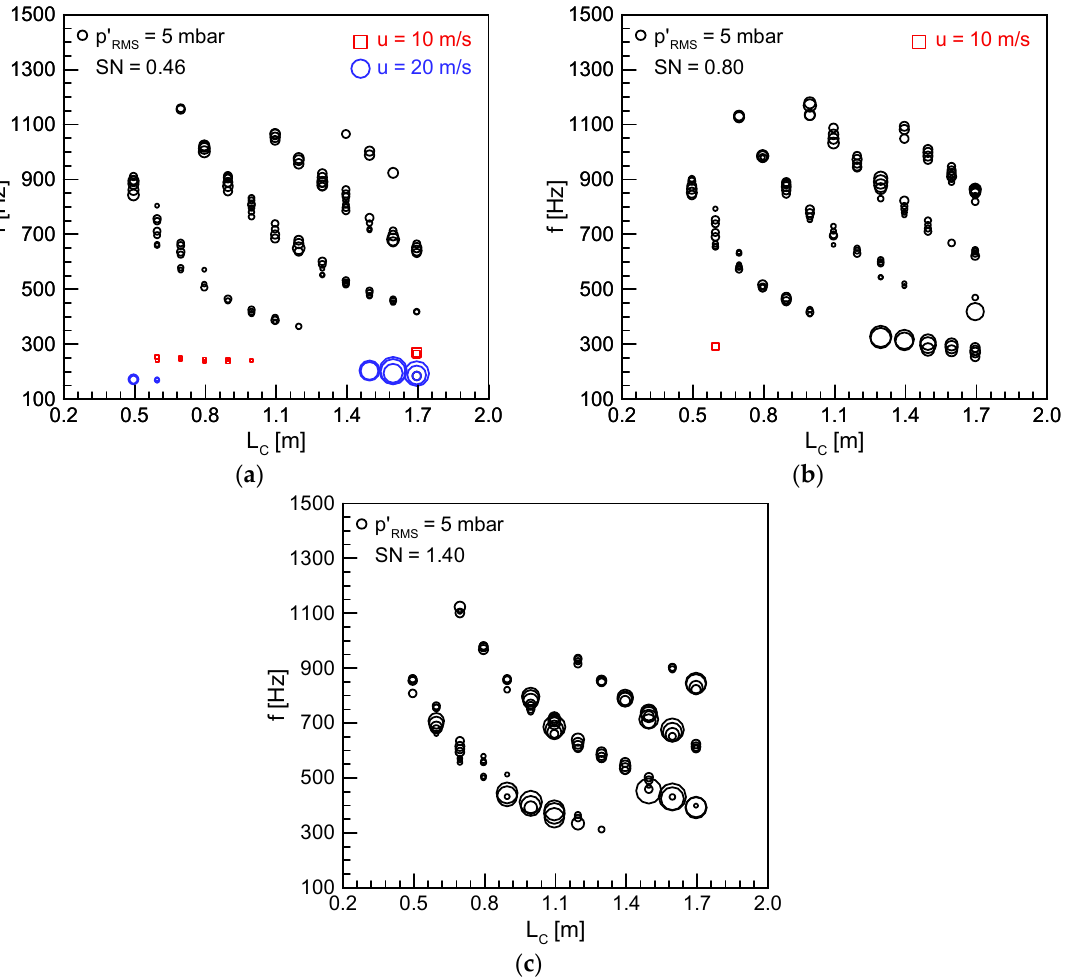
Figure 5. Dominant frequencies and their RMS values as a function of combustion chamber length using CH 4 : ( a ) SN = 0.46, ( b ) SN = 0.80, and ( c ) SN = 1.40.